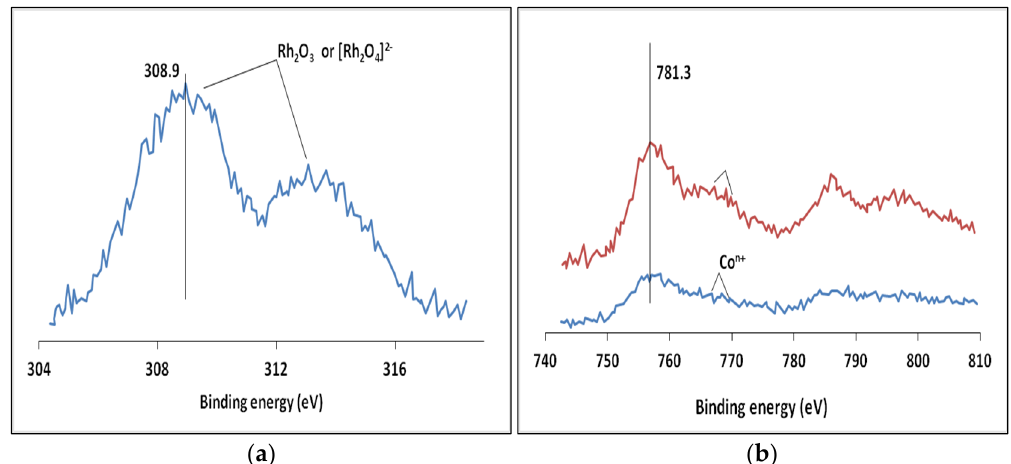
Figure 4. XPS spectra of ( a ) Rh 3d and ( b ) Co 2p levels for 2.5%Co/Al 2 O 3 (1) and 5%Co-Rh(1:1)/Al 2 O 3 (2) catalysts.